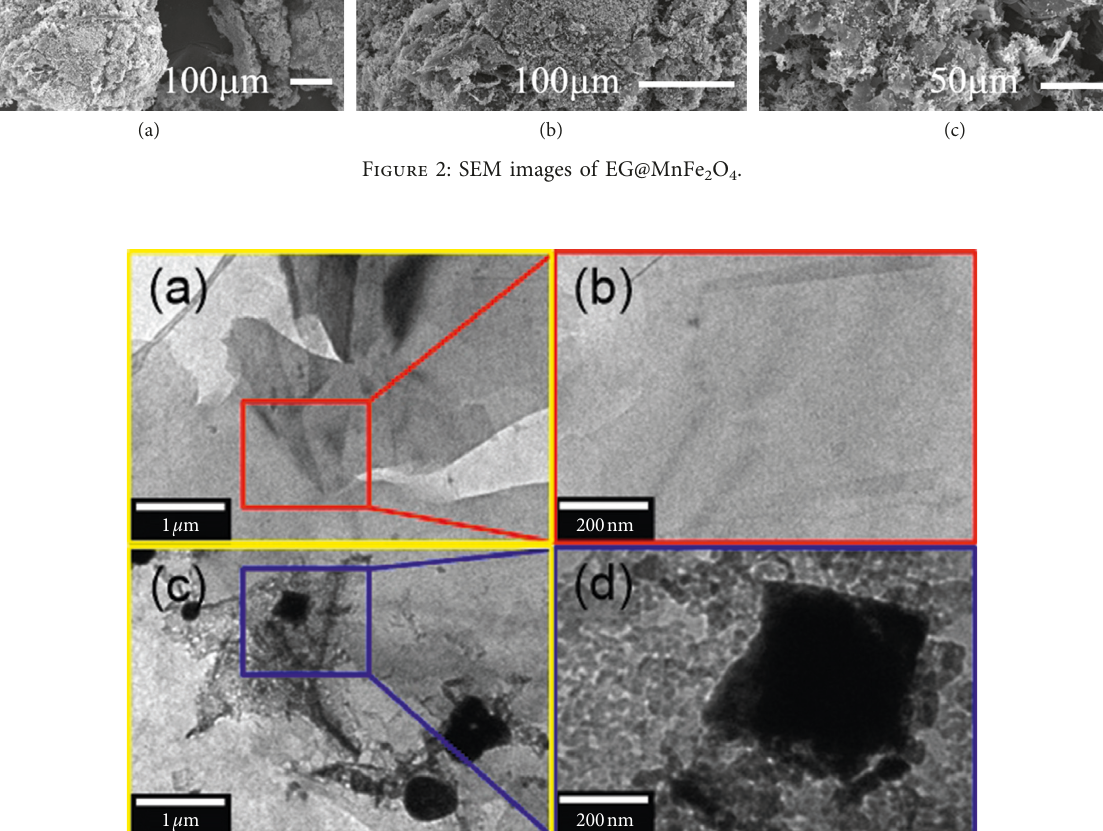
Figure 3: TEM images of EG (a, b) and EG@MnFe